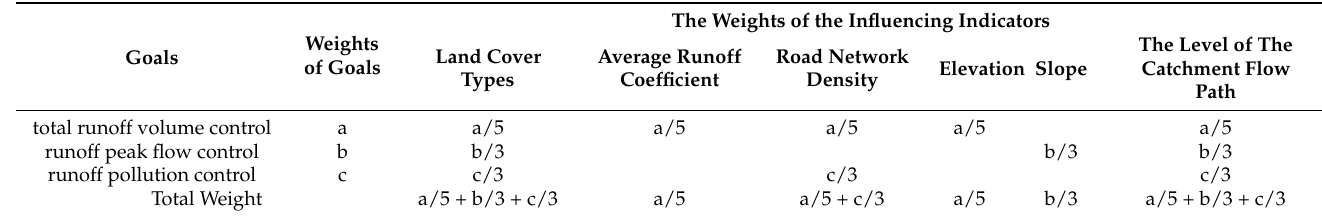
Table 3. Calculation of the weights of the influencing indicators of location decision.